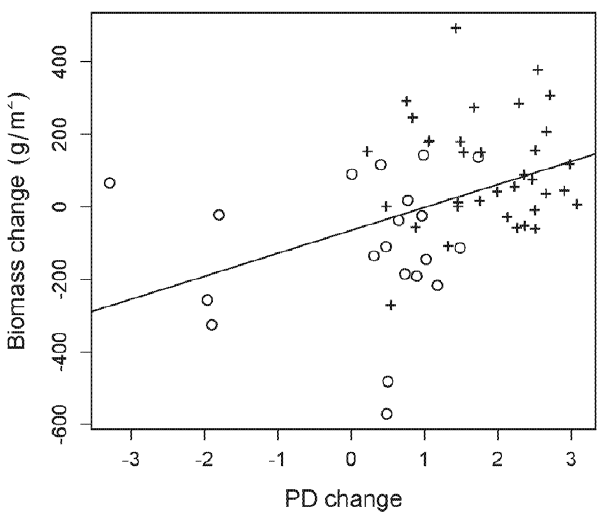
Figure 6. The relationships between the change in PD and change in biomass production. Open circles are plots that were initiated with a legume and ‘ + ’ represents plots not initiated with a legume, but were subsequently colonized by one.